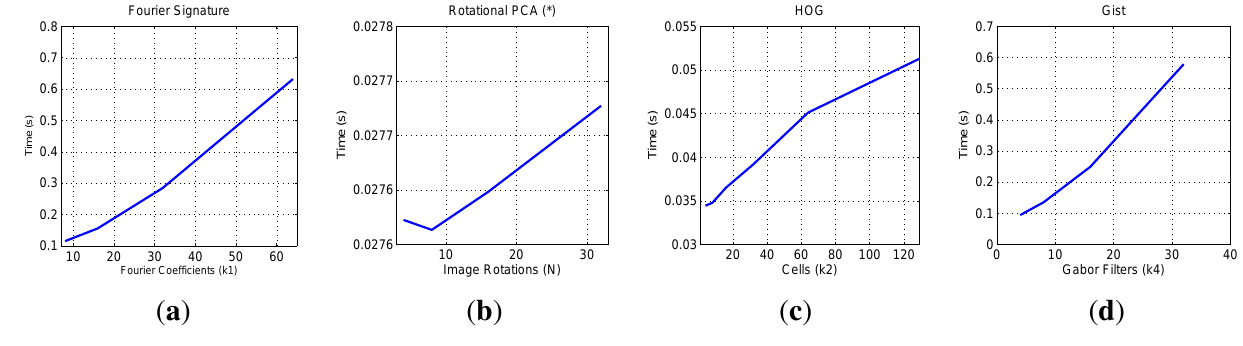
Figure 9. COLD database. Computational cost of the localization